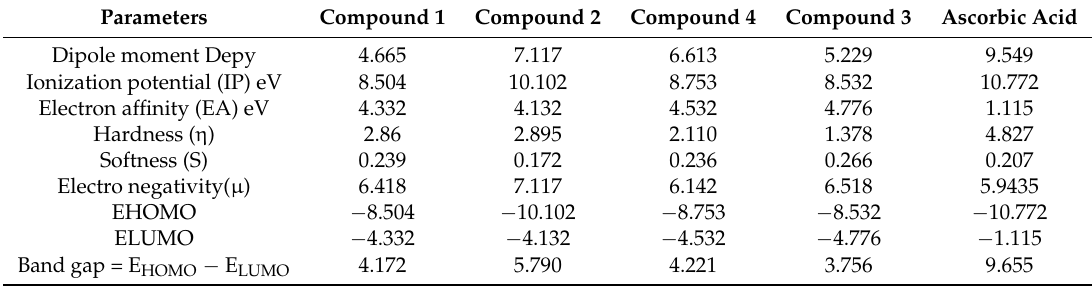
Table 1. Electronic properties of antioxidants 1 – 4 were obtained by using HF method with the 3-21G basis